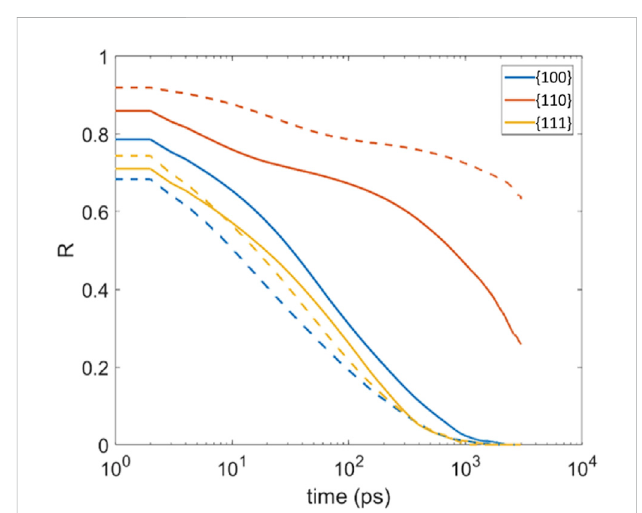
FIGURE 7 Time autocorrelation of percentage of adsorbed molecules (Residence time, denote as R); TCE (solid line) at 230 K and TCB (dash line) at 360 K on the three Pd